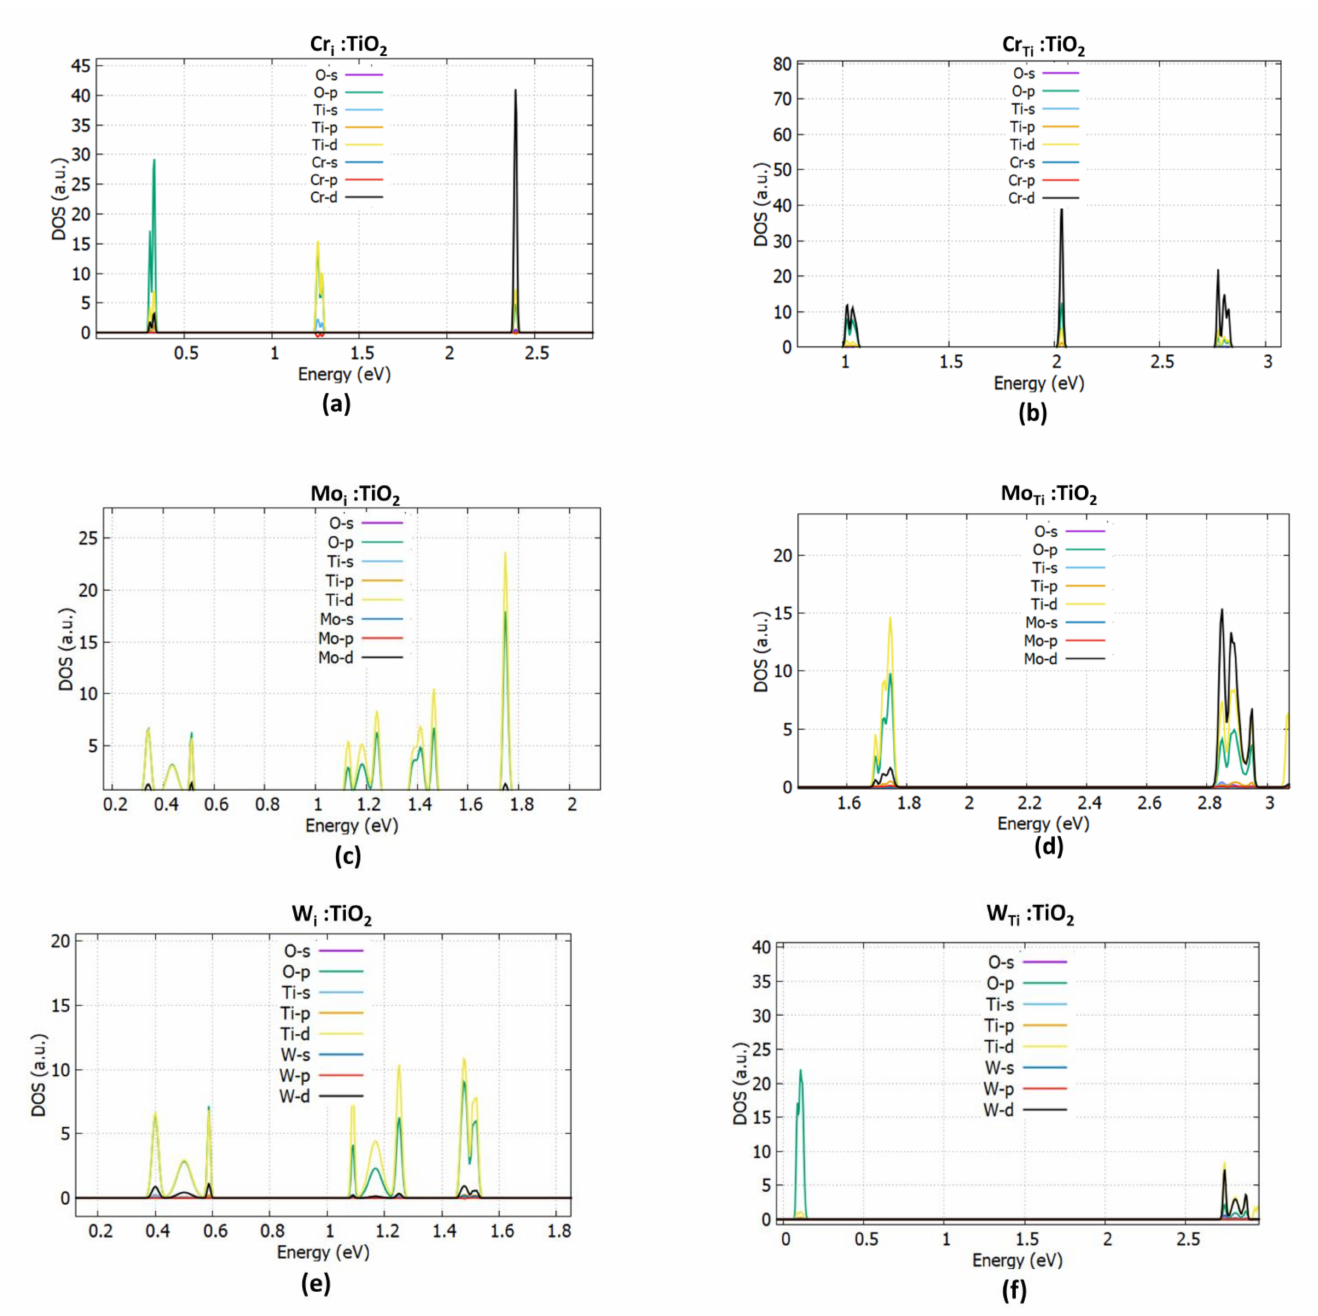
Figure 3. The mid gap states for ( a ) Cr as an interstitial dopant, ( b ) Cr as a substitutional dopant, ( c ) Mo as an interstitial dopant, ( d ) Mo as a substitutional dopant, ( e ) W as an interstitial dopant, ( f ) W as a substitutional